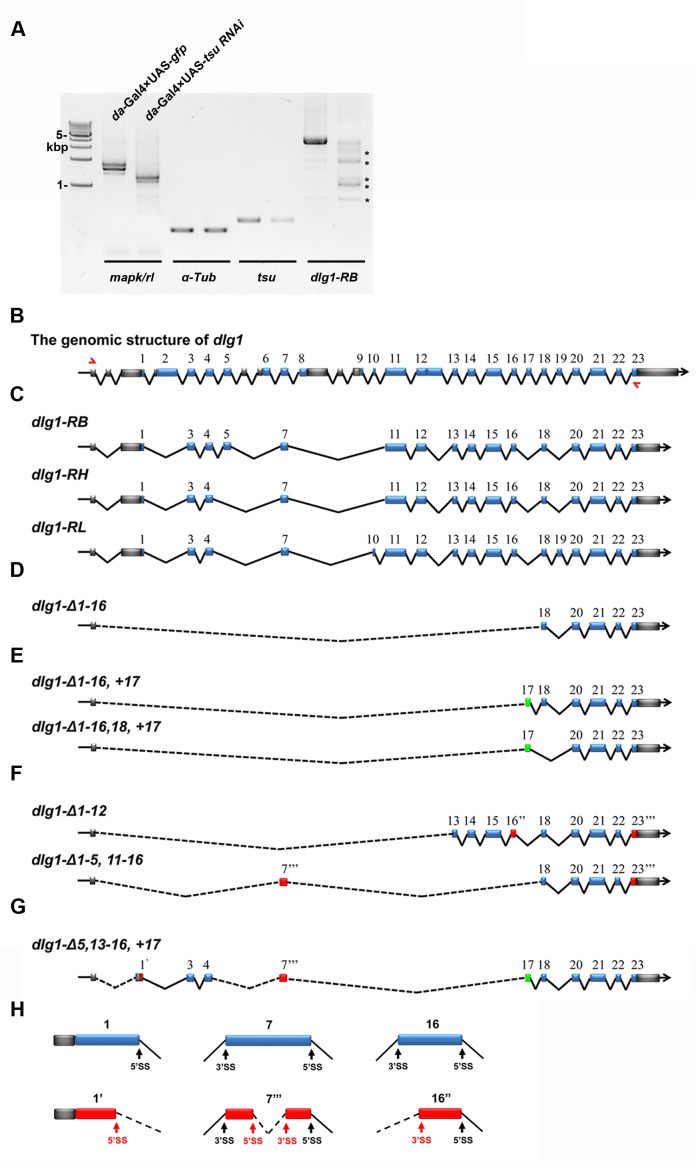
The pre-EJC regulates the precise splicing of dlg1.(A) Aberrant dlg1 transcripts (indicated by asterisks) were detected by RT-PCR in RNA samples prepared from fly larvae expressing tsu RNAi driven by da-Gal4. (B) Shown is the genomic structure of dlg1 that contains 23 coding exons (blue boxes). The positions of primer pairs used to amplify RB, RH and RL splicing isoforms are indicated by red arrows. (C) Shown are RB, RH, RL splicing isoforms that are amplified by the above indicated primer pair. (D–H) Aberrant isoforms indicated by asterisks in panel A. were excised and purified from the agarose gel, cloned into a pGEM-T vector and subsequently subject to sequencing. After comparing the mRNA sequences deduced from sequencing results with wildype RB, RH and RL isoforms, three classes of aberrant splicing events were detected. The first class represents a previously reported exon skipping event, which was observed in all splicing forms (D–G). The second class represents exon inclusion, which contains the exons that are normally efficiently spliced in wildtype isoforms (green boxes). The third class includes exons that are generated by previously unidentified splice sites (SS; red boxes). These three classes are not mutually exclusive as classes 1 and 2 were found in aberrant isoforms shown in panel E, classes 1 and 3 in panel F, and classes 1–3 in panel G. Δ indicates missing exons. 1’ indicates a 5’ SS in exon 1. 16’’ indicates a 3’SS sites in exon 16. 7’’’ and 23’’’ indicate 5’ and 3’ SS present in the exon 7 and 23, respectively. Dashed lines indicate novel ligation of exons. Details on usage of previously unidentified splice sites are shown (H).